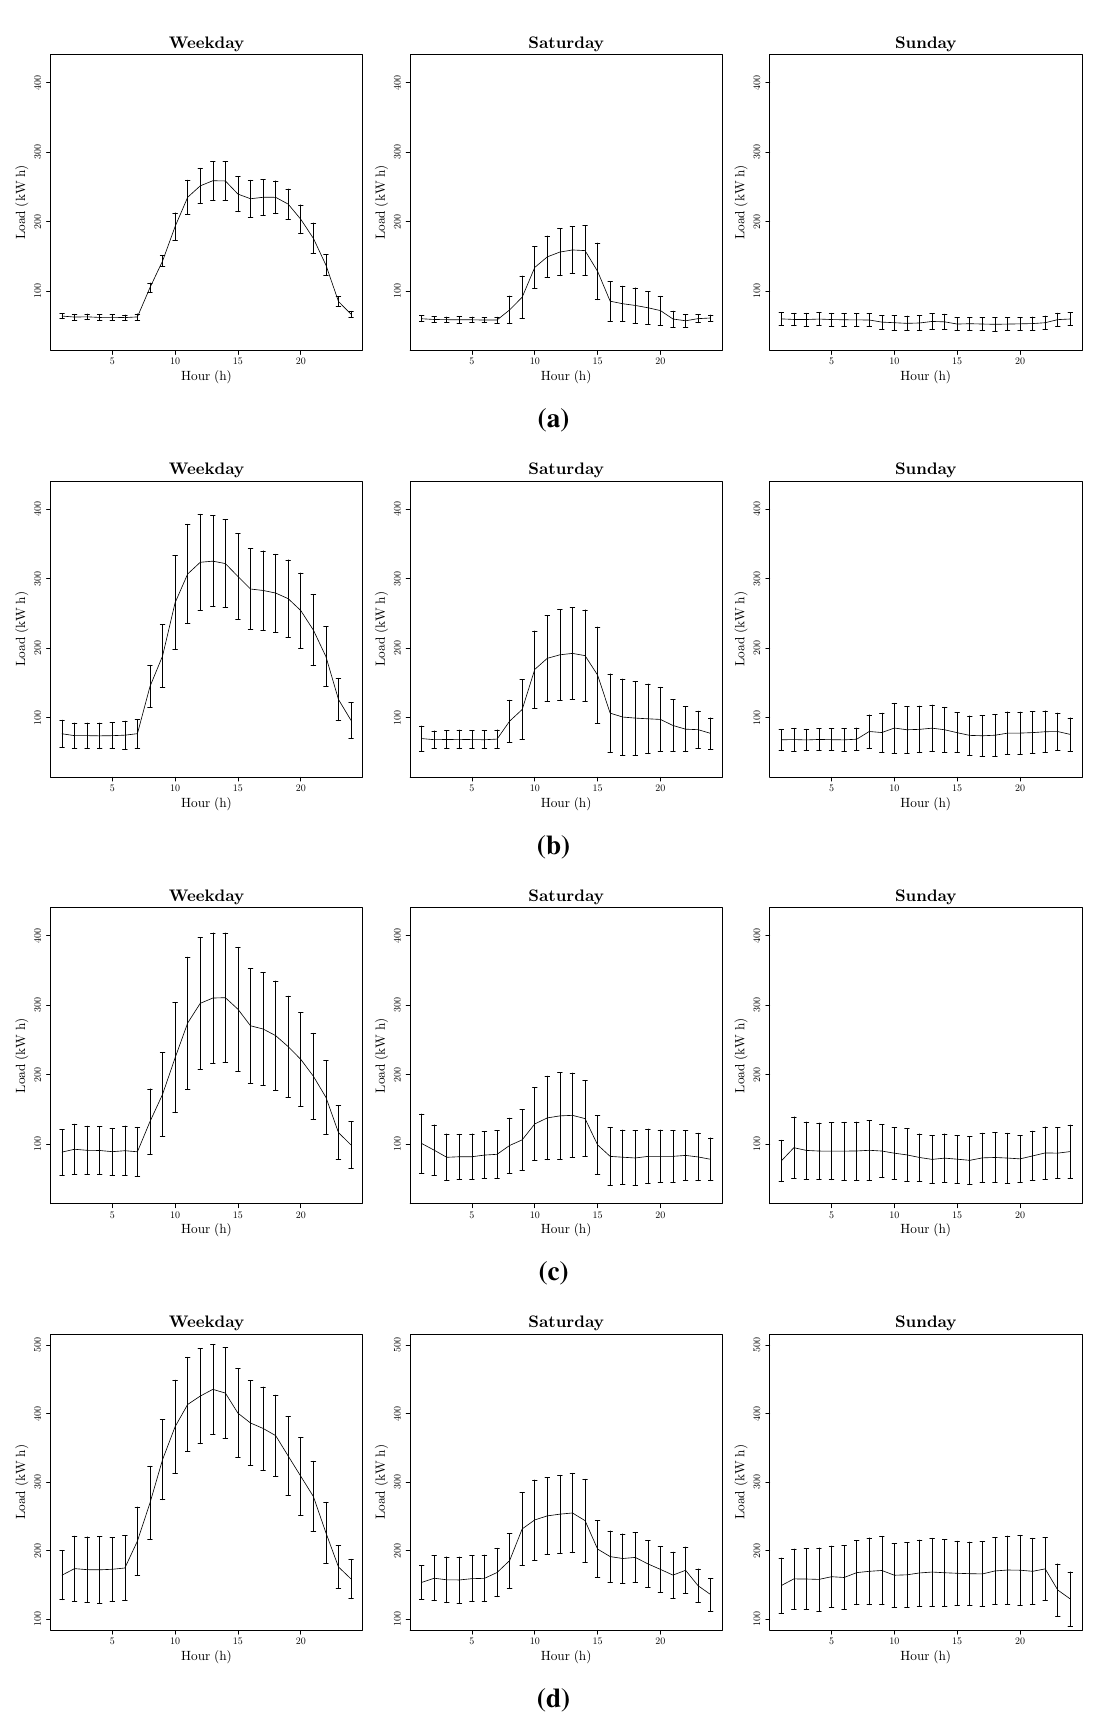
Figure 3. Typical load for the dataset with three day-types. Average daily load ( kW h ). Error bars denotes ± σ . ( a ) Dataset donosti ( d ) Dataset donosti 4